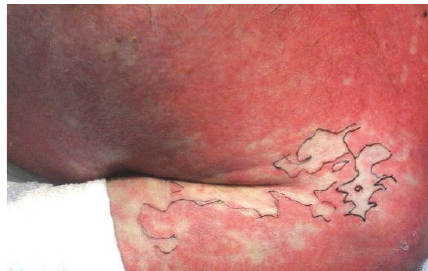
Table 1: Prognosis score for TEN (SCORTEN) [5]. Determination on admission. A point is given for a fulfilled criterion. Rating of